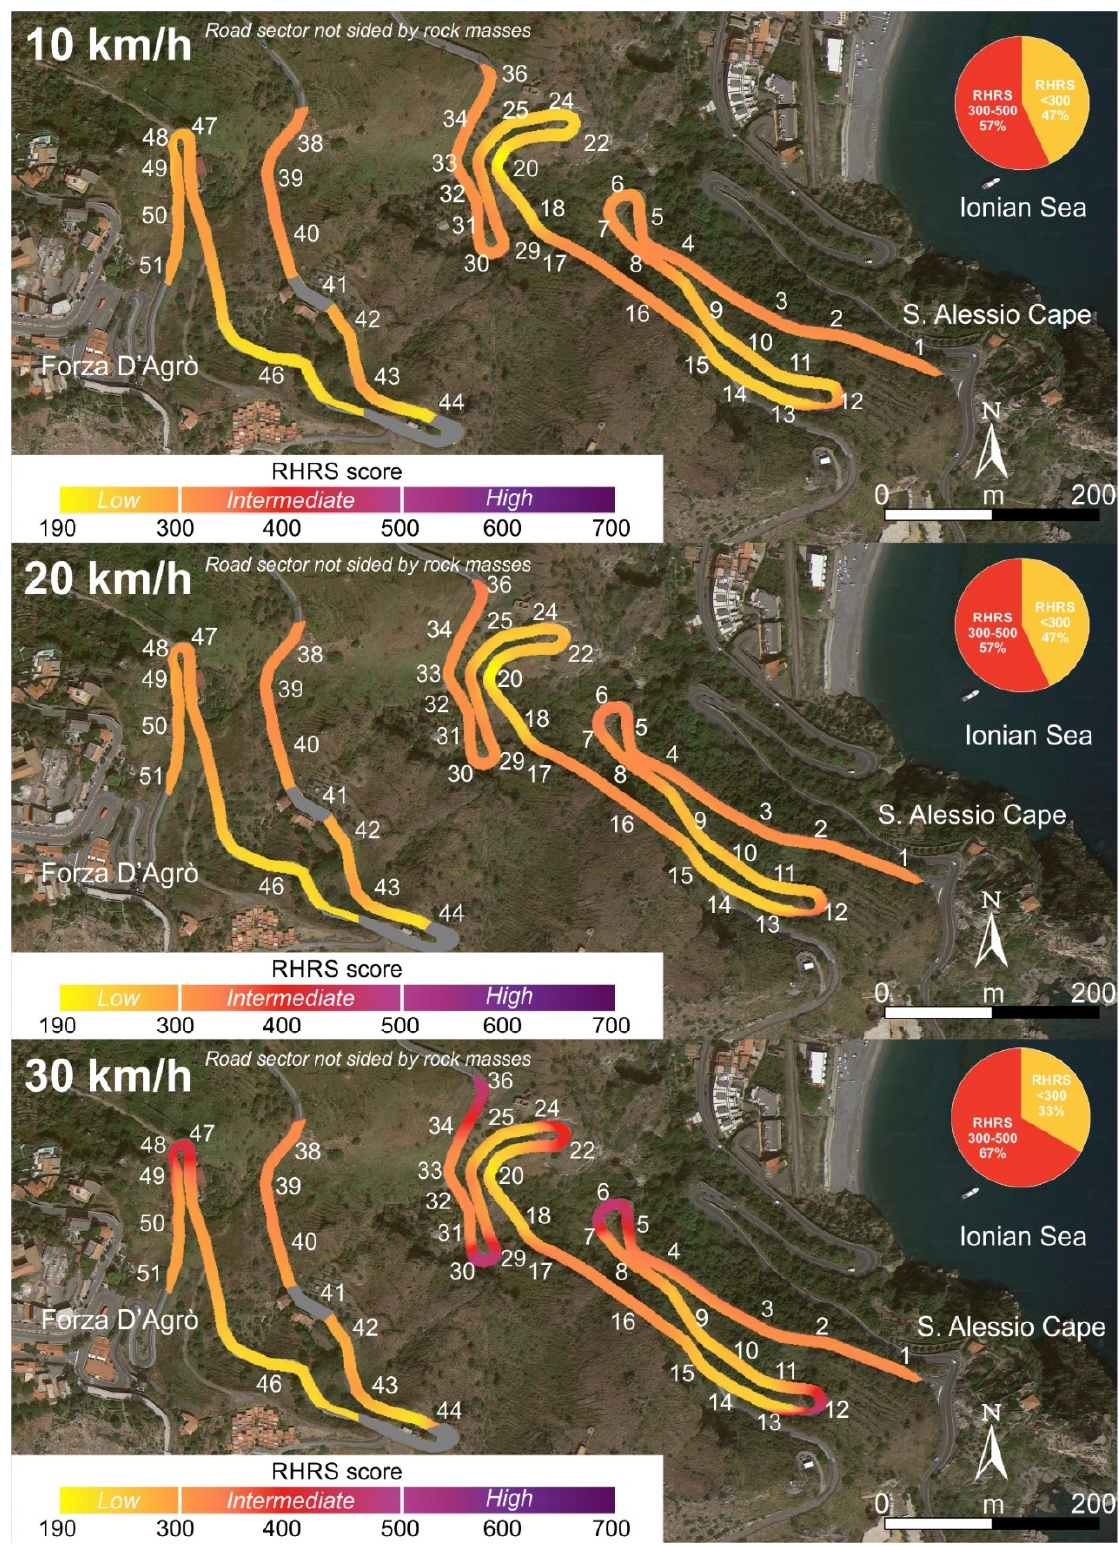
Figure 5. Risk maps for 10, 20, and 30 km/h vehicle speed scenarios considered. Numbers along the road path indicate the most representative sub-segments considered for the computation of the RHRS score. The gray band indicates road segments surrounded by no rock masses.